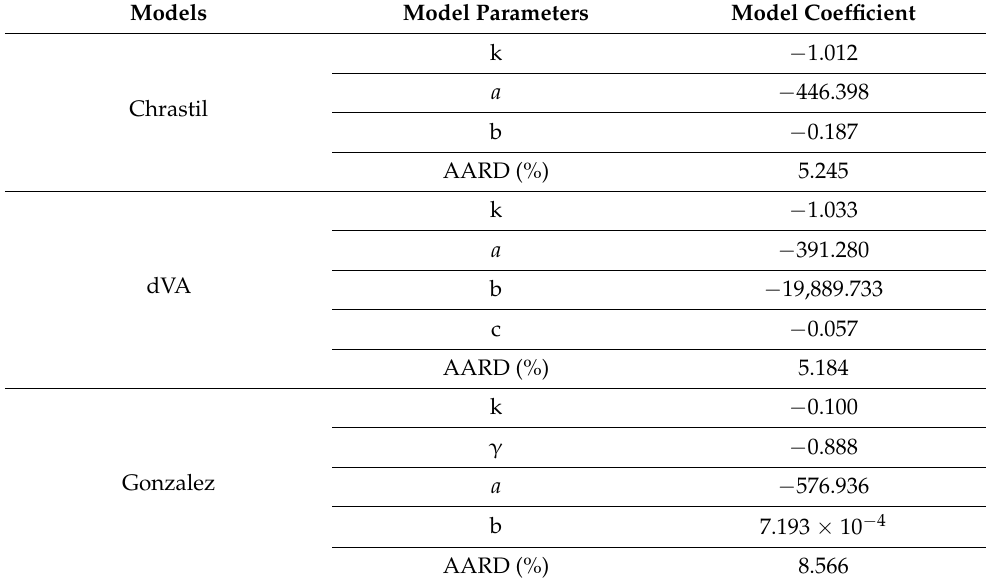
Table 3. Correlations results of the solubility of RA by semi-empirical models. Models Model Parameters Model